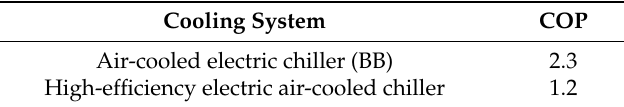
Table 10. Investigated cooling primary systems.